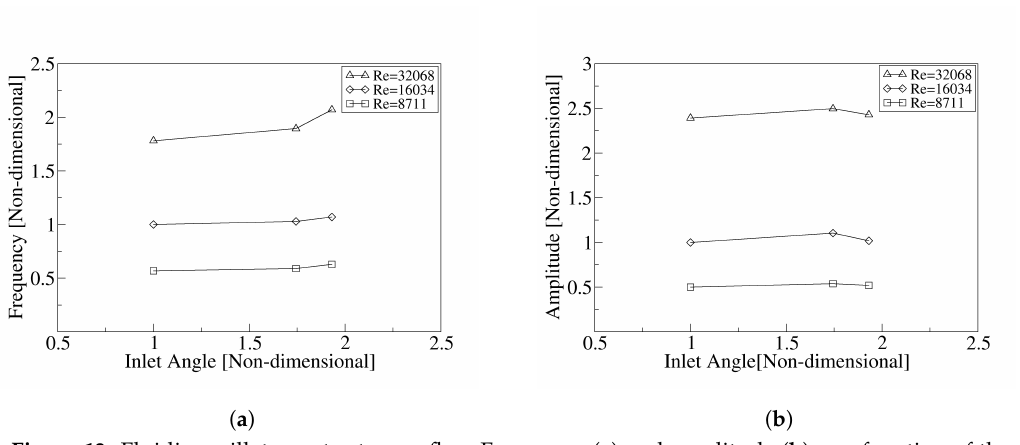
Figure 13. Fluidic oscillator output mass flow Frequency ( a ) and amplitude ( b ) as a function of the mixing chamber inlet angle and for three different Reynolds numbers, 8711, 16034 and